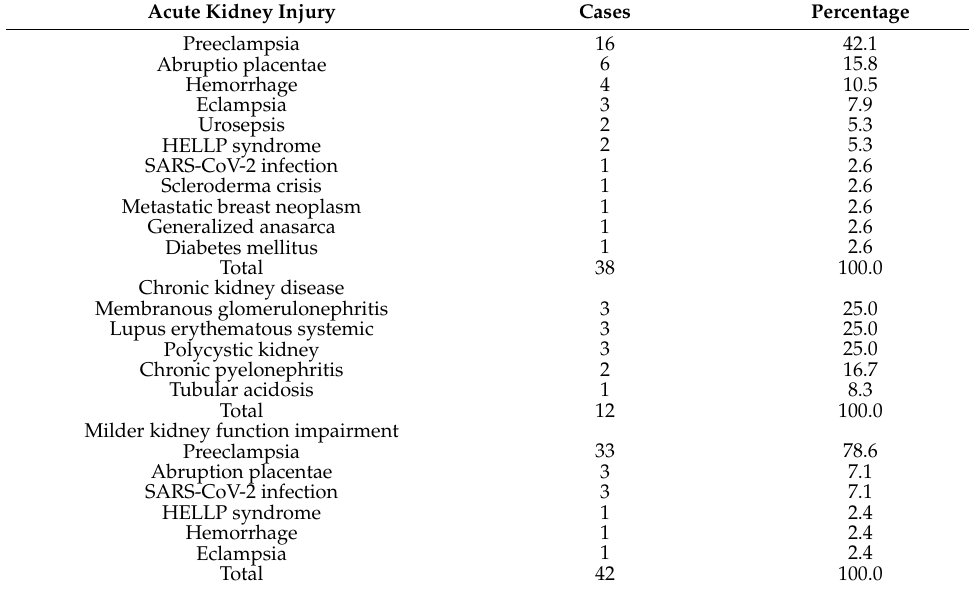
Table 2. Distribution of underlying pathology/trigger